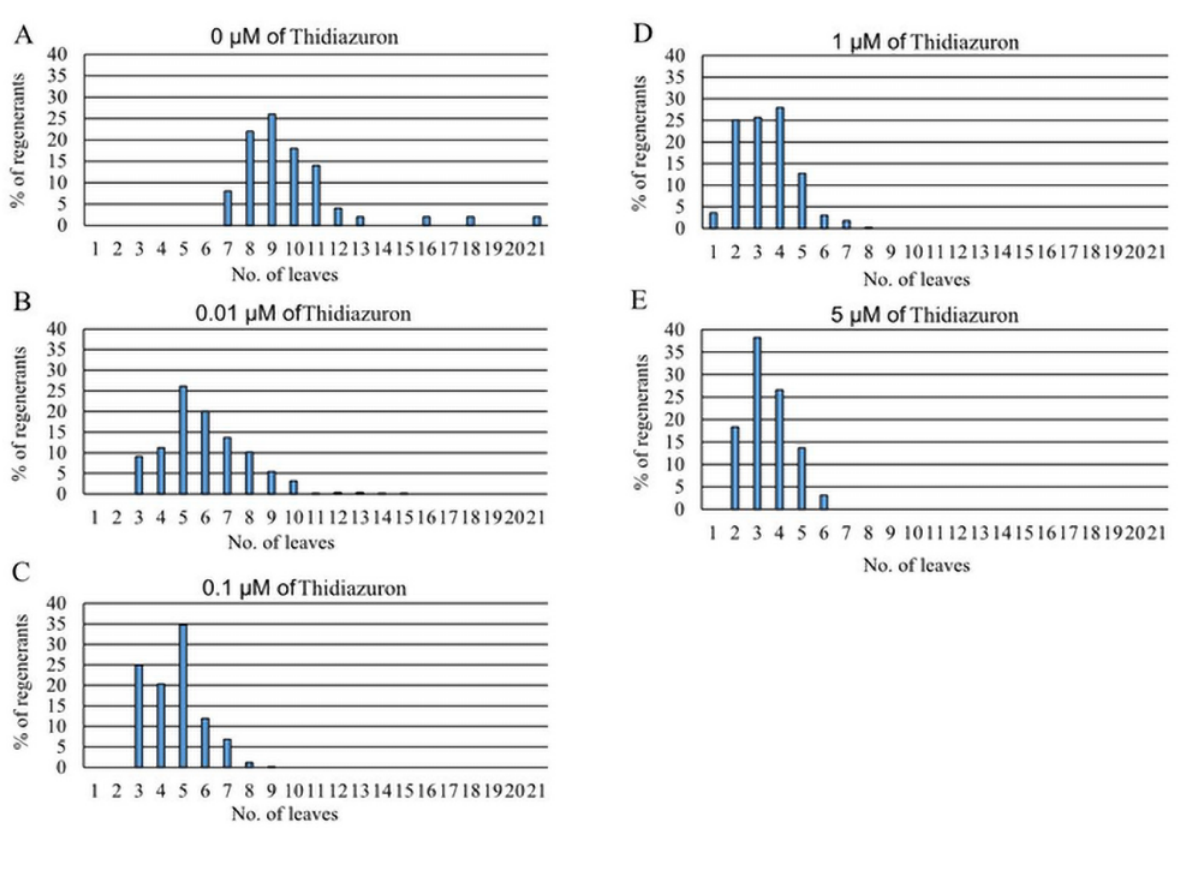
Figure 5 Percentage of regenerants showing variable number of leaves (developmental determinant) according to the thidiazuron [TDZ; 1-phenyl-3-(1,2,3-thiadiazol-5-yl)-urea)] concentration in initial culture medium 1/2 Murashige and